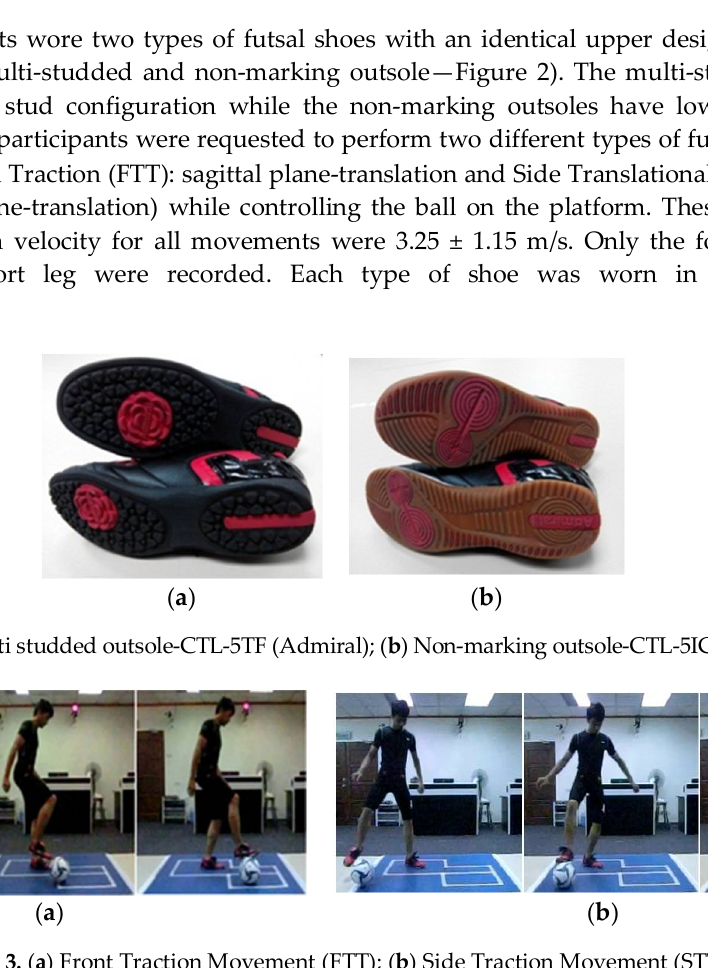
Figure 3. ( a ) Front Traction Movement (FTT); ( b ) Side Traction Movement